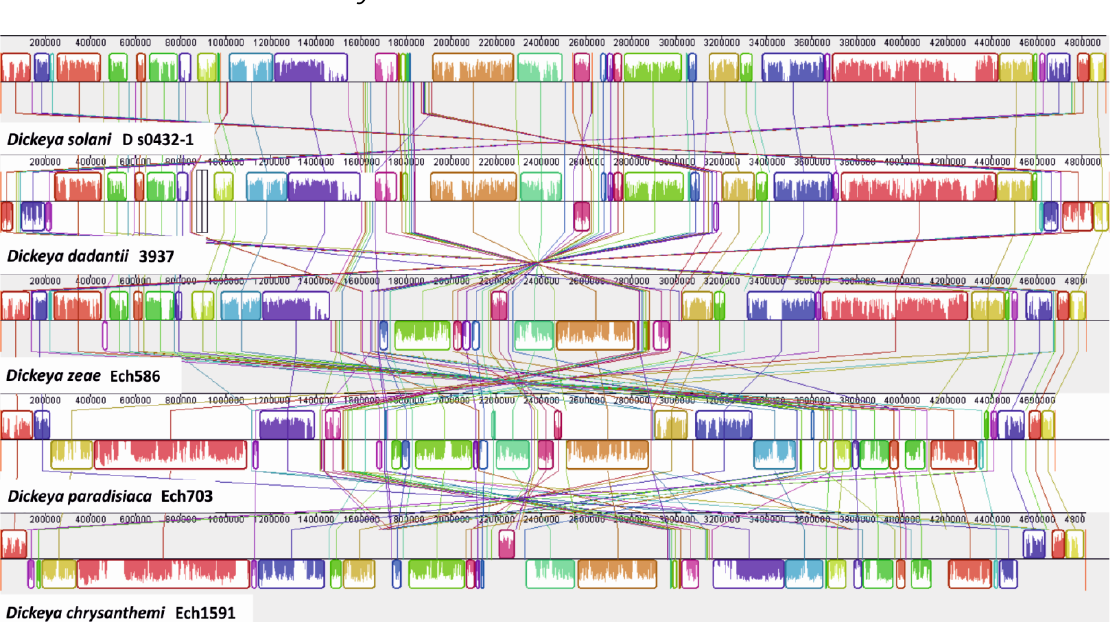
Figure 1. Synteny of the D. solani D s0432-1 genome and genomes of other Dickeya strains. Pairwise alignments of genomes were generated using Mauve. Colored outlined blocks surround the regions of the genomic sequence that aligned to another genome. The colored bars inside the blocks are related to the level of sequence similarities. The